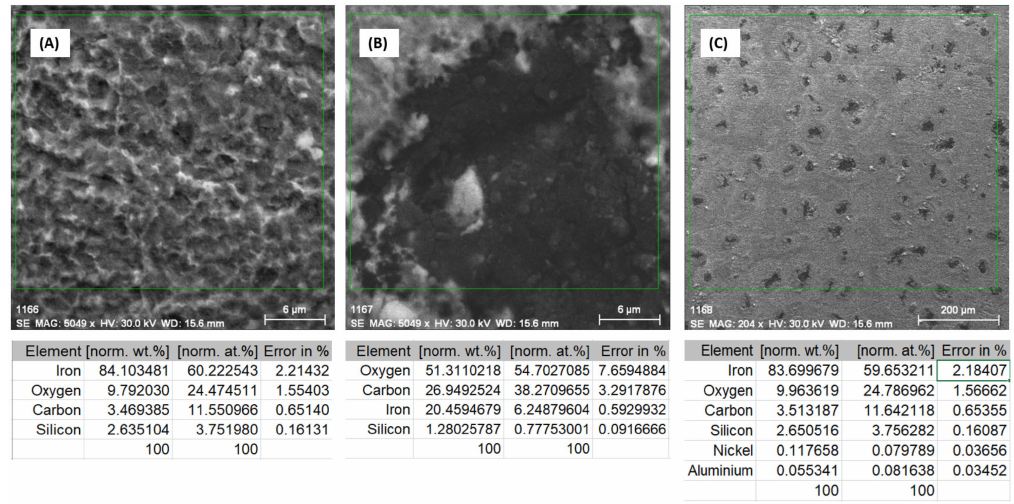
Figure 8. Morphology and chemical composition on various areas of the studied sample surface immersed in DWW-2: ( A ) Zone A, ( B ) Zone B and ( C ) Zone